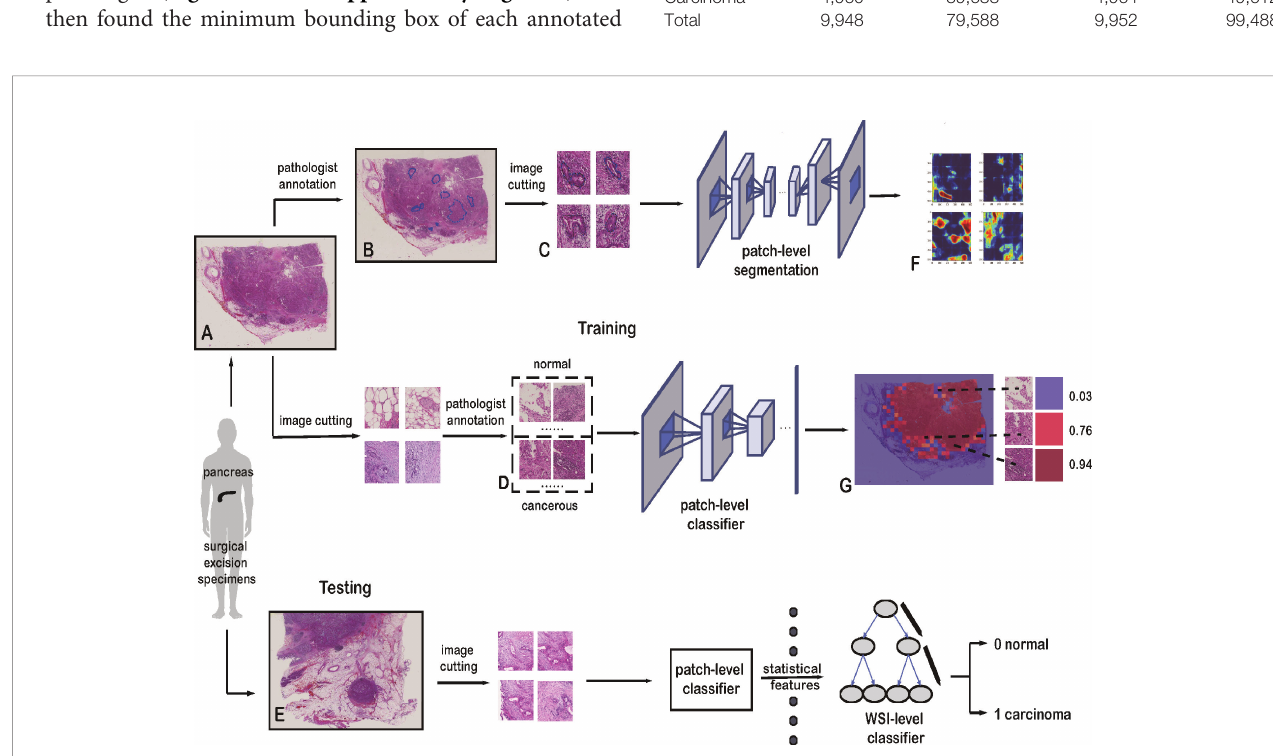
FIGURE 1 | Framework of the deep-learning approach. (A) Training data with raw WSIs. (B) Annotated WSIs. (C) Patches for training the patch-level segmentation. Each patch has a region with carcinoma. (D) Two classes of patches for training the patch-level classi fi er. (E) Testing data with raw WSIs. (F) Heatmap, as the output of the patch-level segmentation. (G) Malignant probability heatmap.